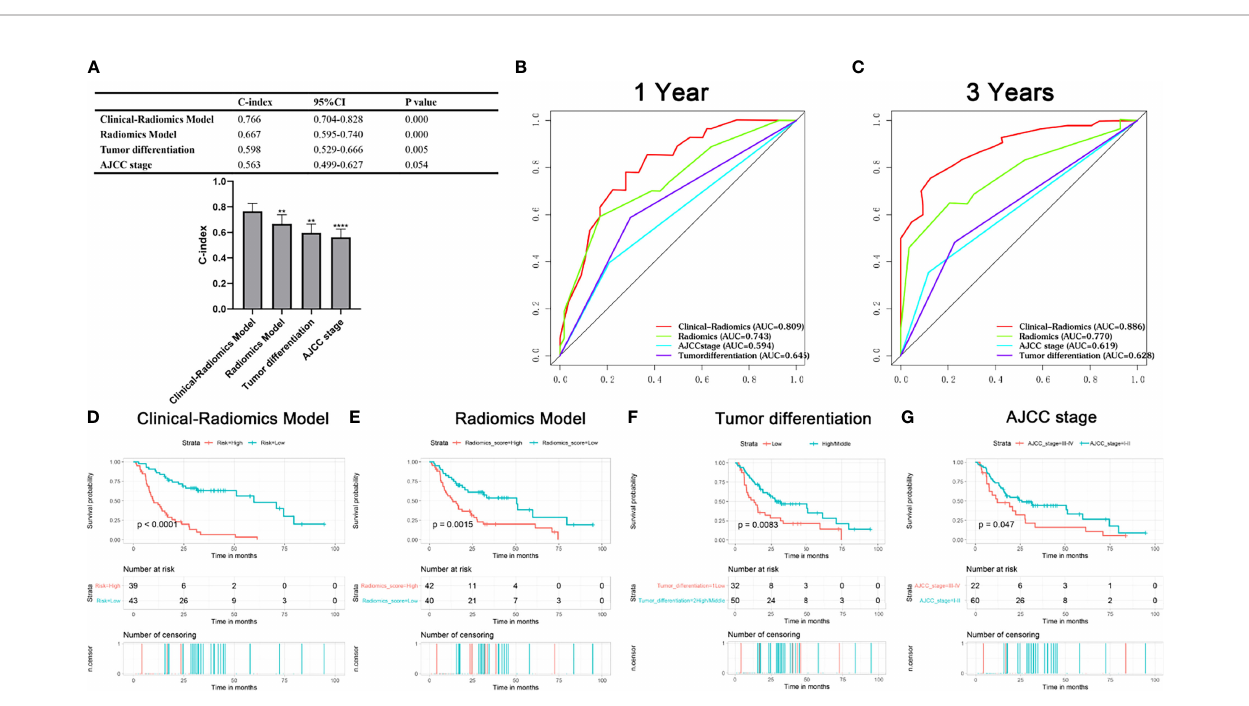
FIGURE 7 | Kaplan-Meier survival curve, C-index, and AUC were compared among the models. (A) C-index of models; (B, C) AUC of the models for predicting OS at 1, and 3 years; (D – G) Kaplan-Meier survival curve showed OS risk strati fi cation by the clinical-radiomics model, radiomics model, tumor differentiation systems and AJCC 8th edition for ICC